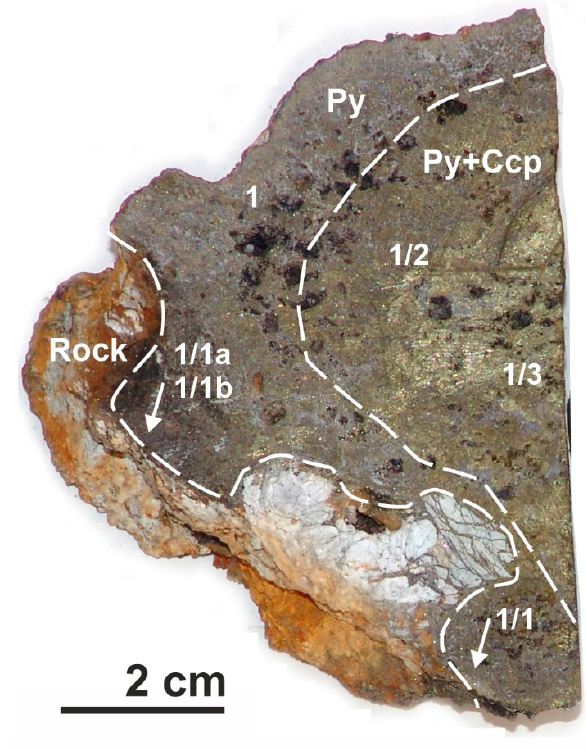
Figure 3. A general view of sample 242-1 with zonal texture.